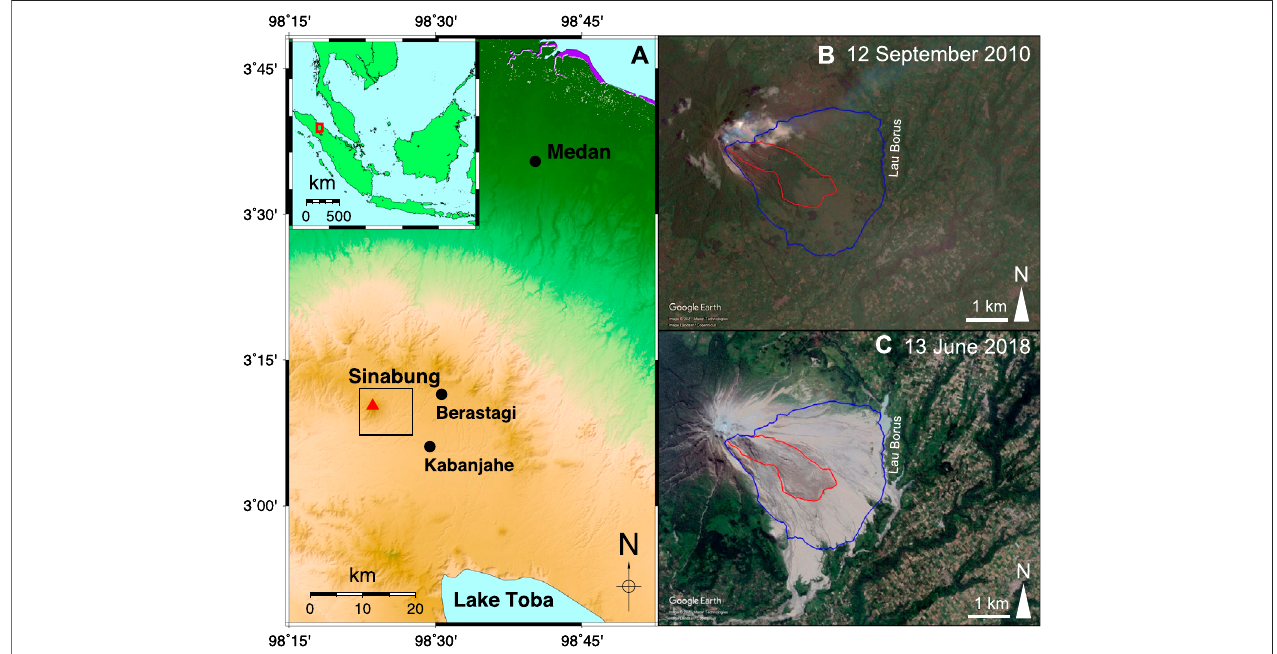
FIGURE 1 | Location of Sinabung Volcano. (A) Sinabung Volcano is located in the Karo Regency of North Sumatra, Indonesia (modi fi ed from Carr et al., 2019a). Satellite images from before (B) and during (C) the eruption show the extensive coverage of deposits from PDCs and the 2014 lava fl ow (red outline). The blue outline shows the extent of our 2018 data and is the area used for the erupted volume